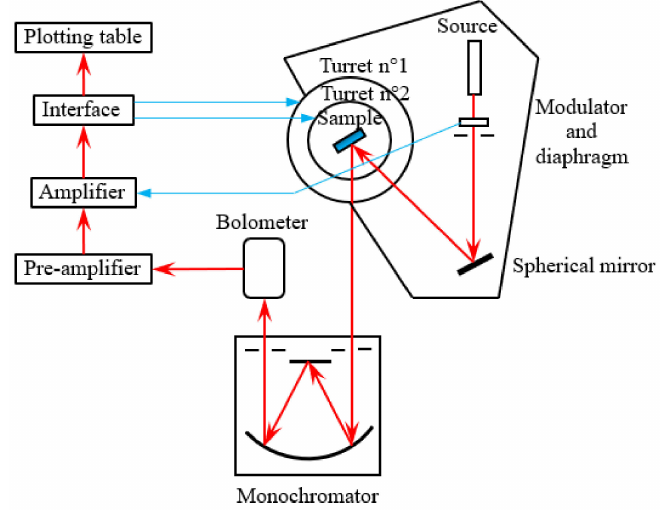
Figure 4. Bi-directional transmission/reflection spectra measurement system based on the grating monochromator [29].